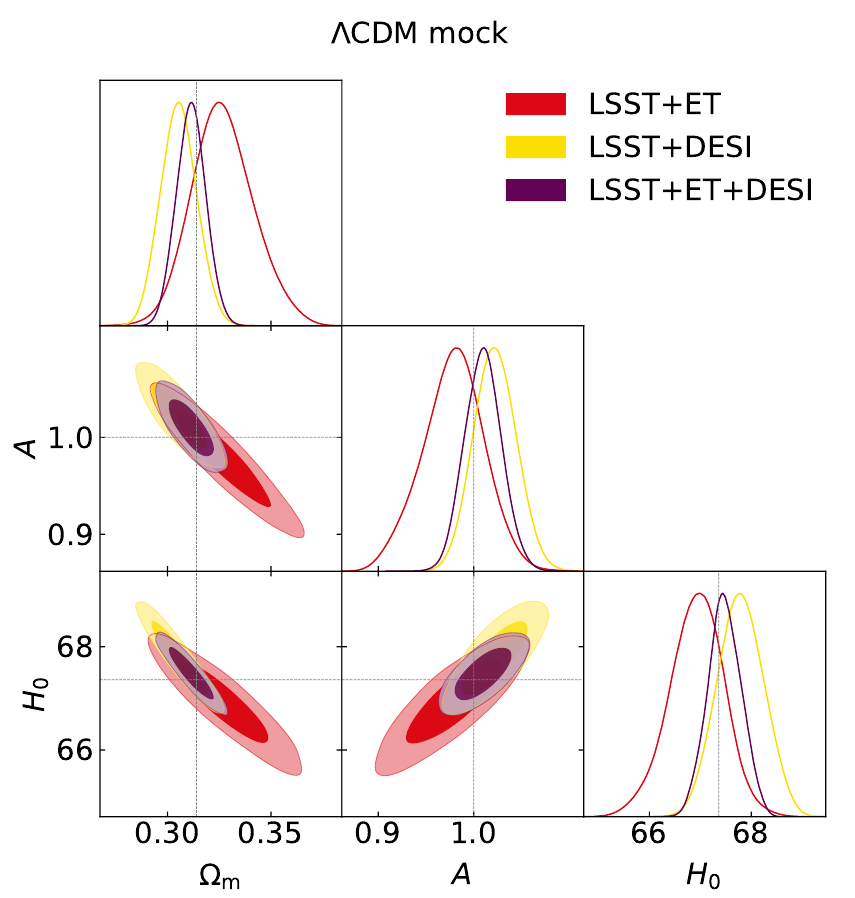
Figure 10. Constraints on cosmological parameters and on the DDR breaking parameter A. The results are obtained for LSST+ET (red), LSST+DESI (yellow) and LSST+ET+DESI (purple). This figure is taken from in